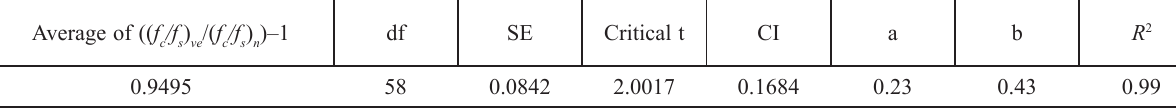
/f ) /( f /f ) )–1 df c s ve c s n